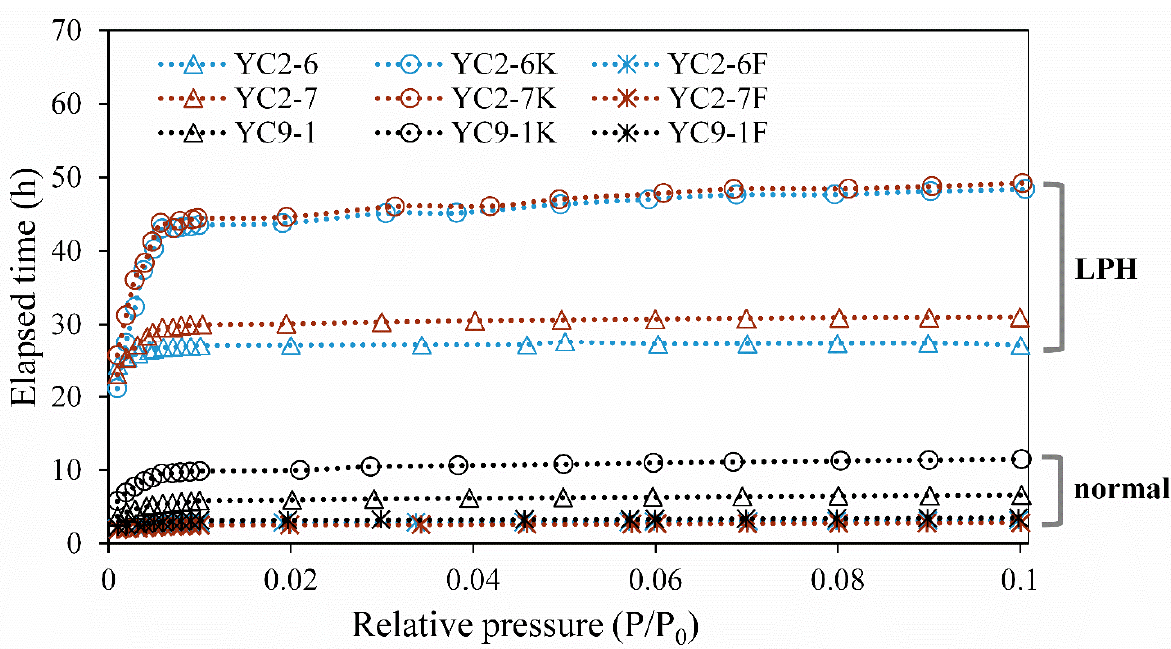
Figure 16. Adsorption equilibrium duration of different types of samples with or without a LPH. See details in text.